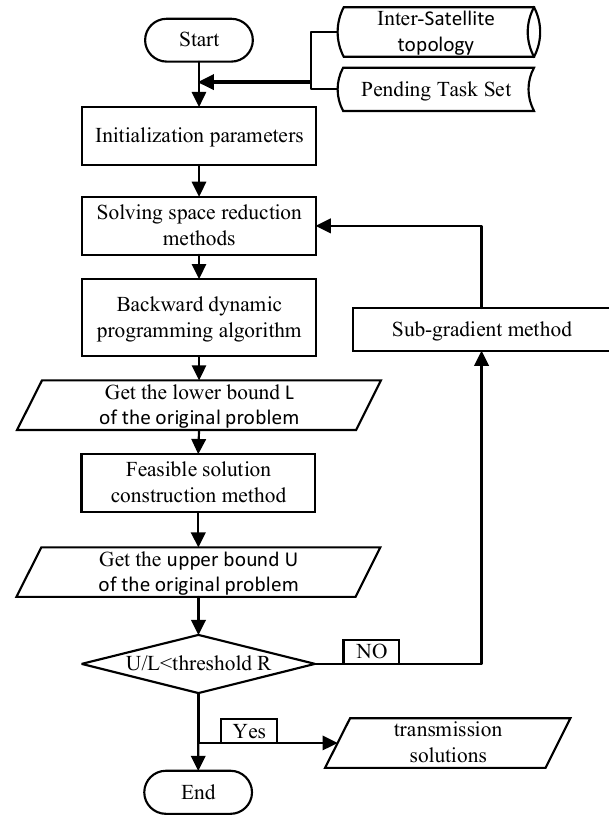
Figure 4. Lagrangian relaxation solving framework.